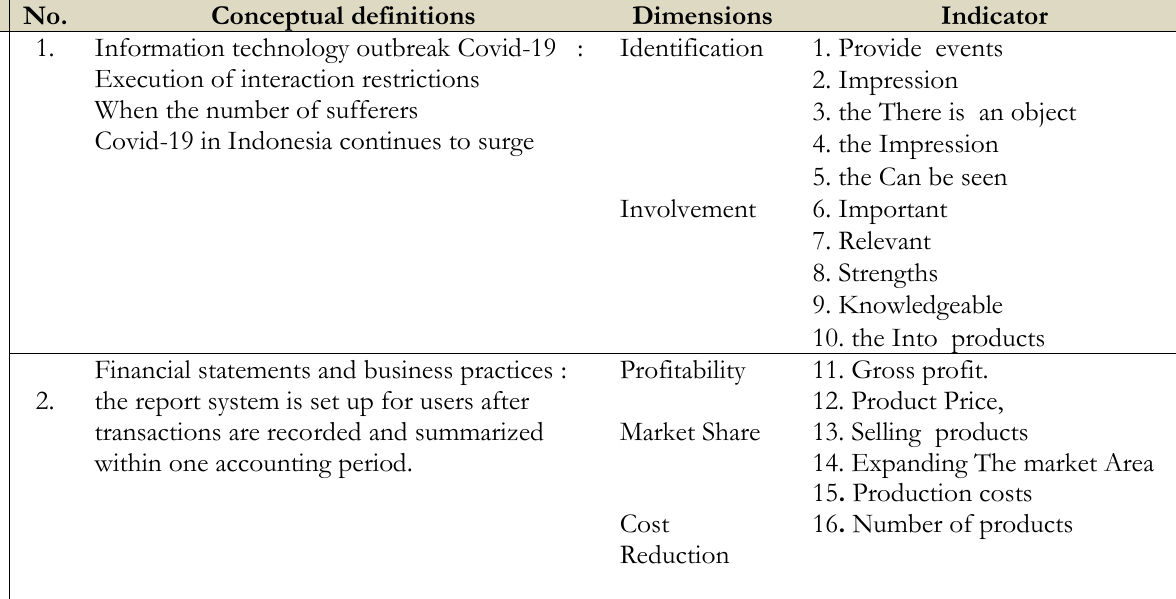
Table 1. Variable Dimensions and Indicator